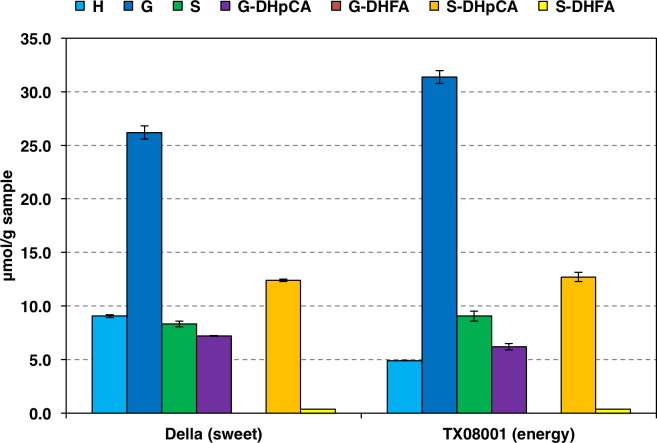
Monolignol and monolignol hydroxycinnamate conjugate concentrations released from TX08001 and Della stems by DFRC.Error bars represent standard error of mean. H; 4-hydroxycinnamyl alcohol, G; coniferyl alcohol, S; sinapyl alcohol, G-DHpCA; coniferyl dihydro-p-coumarate, G-DHFA; coniferyl dihydroferulate, S-DHpCA; sinapyl dihydro-p-coumarate, S-DHFA; sinapyl dihydroferulate, all as their diacetates. Data were obtained from two technical replicates of two biological replicates for both TX08001 and Della (experiments 2 and 3).